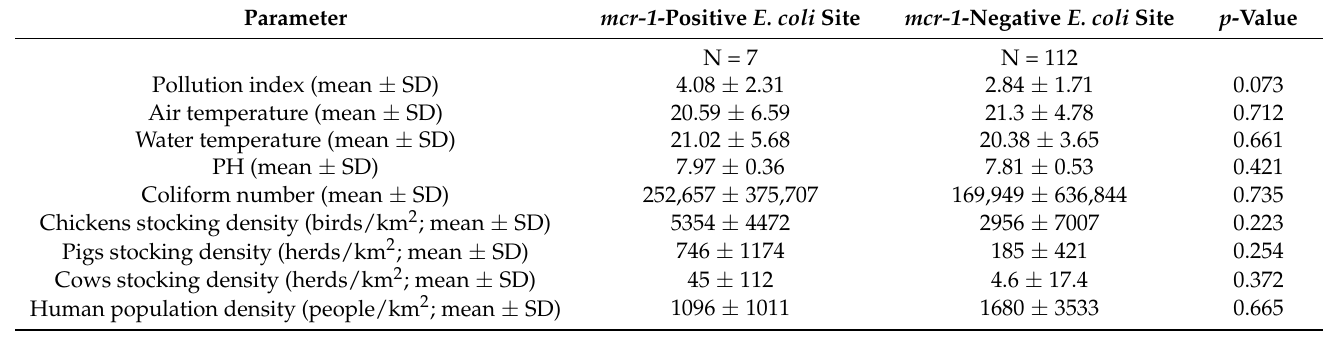
Table 2. Independent t -test of the mcr-1 -positive and mcr-1 -negative E. coli sites.